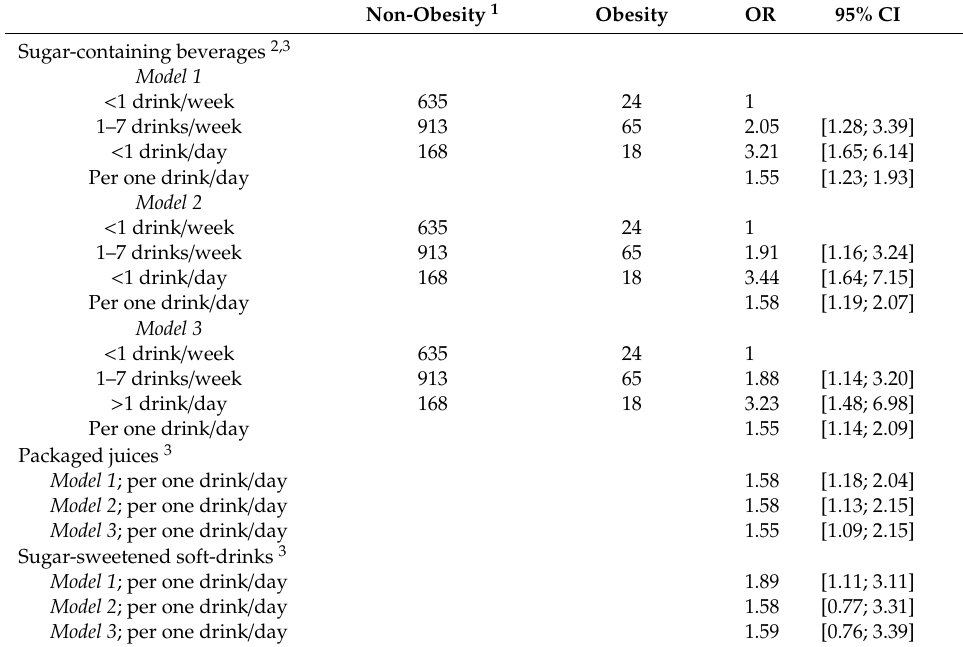
Model 1: Adjusted for age and sex of the children ( n = 1823). Model 2: Adjusted for variables model 1 and parental BMI, weight-gain during pregnancy, mother’s age, mother educational level, mother social class, child